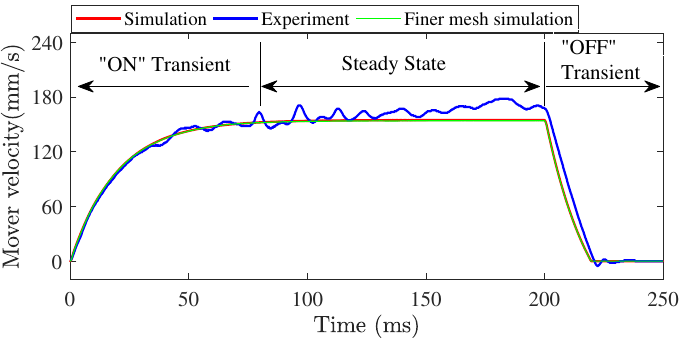
Figure 21. Comparison between simulation and experiment results of the mover transient velocity.